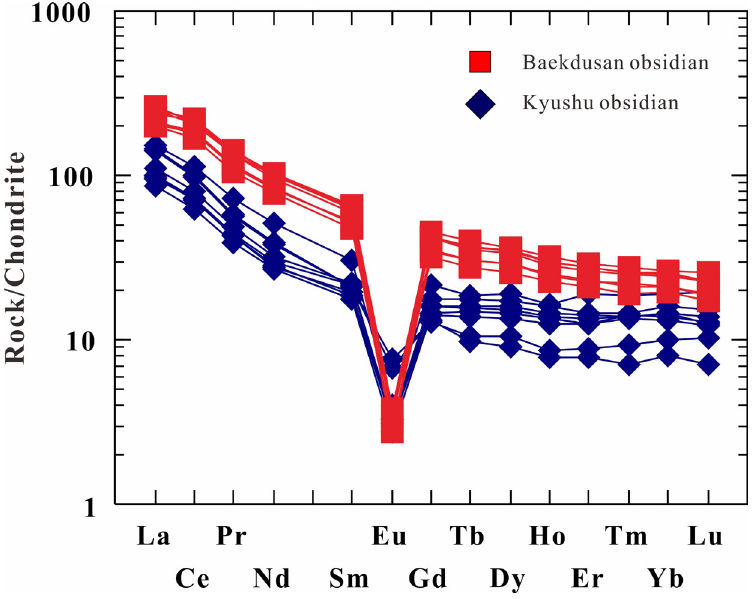
Figure 9. Chondrite-normalized rare earth elements (REEs) patterns for the Baekdusan and Kyushu obsidians. The chemical contrast between the Baekdusan and Kyushu obsidians would have come from the different parental magma genesis. The Baekdusan and the Kyushu volcanic fields are geologically different in the tectonic environment. Baekdusan volcanism occurred within the anorogenic continental environment, whereas Kyushu volcanism is the product of the active subduction zone magmatism (Zou et al., 2008; Zhao & Liu, 2010). This environmental contrast resulted in the different geochemical characteristics of the volcanic magma, essentially leading to the different chemical composition of the obsidians. Yi & Jwa (2016) investigated the tectonic contrast between the two areas using Pb isotopic composition of obsidian, and found that the Baekdusan obsidians have higher isotopic ratios of 208 Pb/ 204 Pb and 207 Pb/ 204 Pb at a given 206 Pb/ 204 Pb ratio, indicating that the crustal components were highly engaged in generating volcanic magma. On the other hand, the Kyushu volcanic rocks have lower Pb isotopic ratios which are indicative of the relative contribution of mantle component to the volcanic